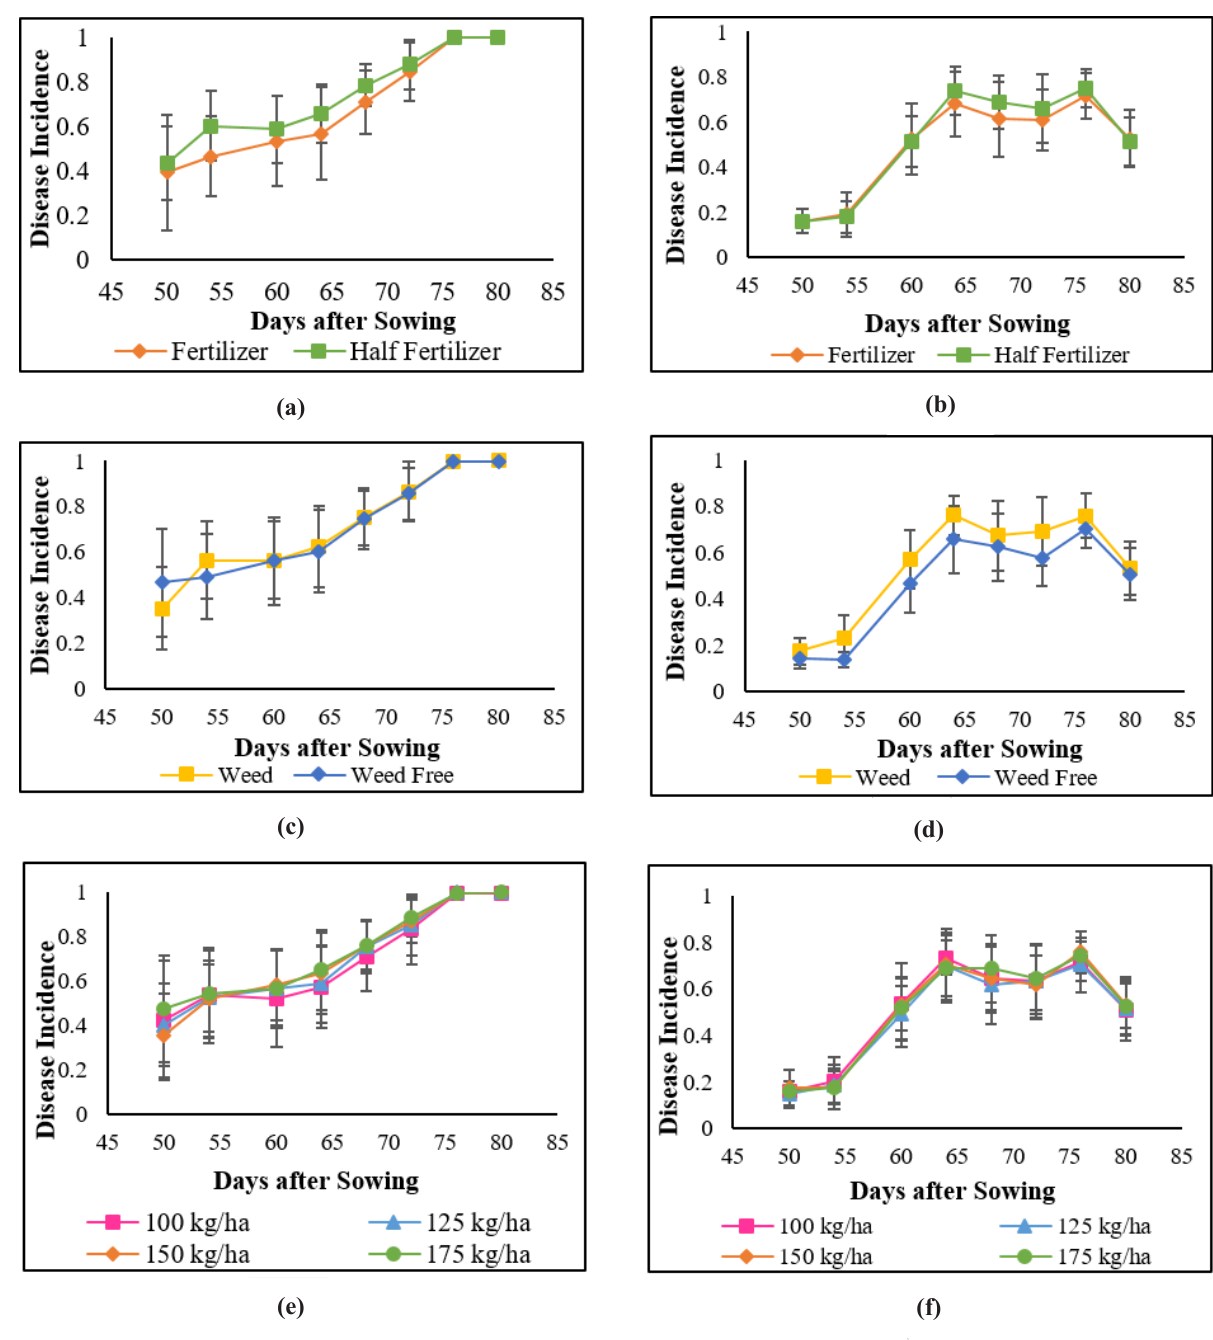
Figure 1: Incidence of NBLS within the applied treatments in 2017/2018 Maha season and 2018 Yala season: (a) Incidence of NBLS with nitrogen rate in 2017/2018 Maha season excluding the effect of weed infestation and seed rate; (b) Incidence of NBLS with nitrogen rate in 2018 Yala season excluding the effect of weed infestation and seed rates; (c) Incidence of NBLS with presence and absence of weeds in 2017/2018 Maha season excluding the effect of nitrogen rate and seed rate; (d) Incidence of NBLS with presence and absence of weeds in 2018 Yala season excluding the effect of nitrogen rate and seed rate; (e) Incidence of NBLS with different seed rates in 2017/2018 Maha season excluding the effect of nitrogen rate and weed infestation; (f) Incidence of NBLS with different seed rates in 2018 Yala season excluding the effect of nitrogen rate and weed